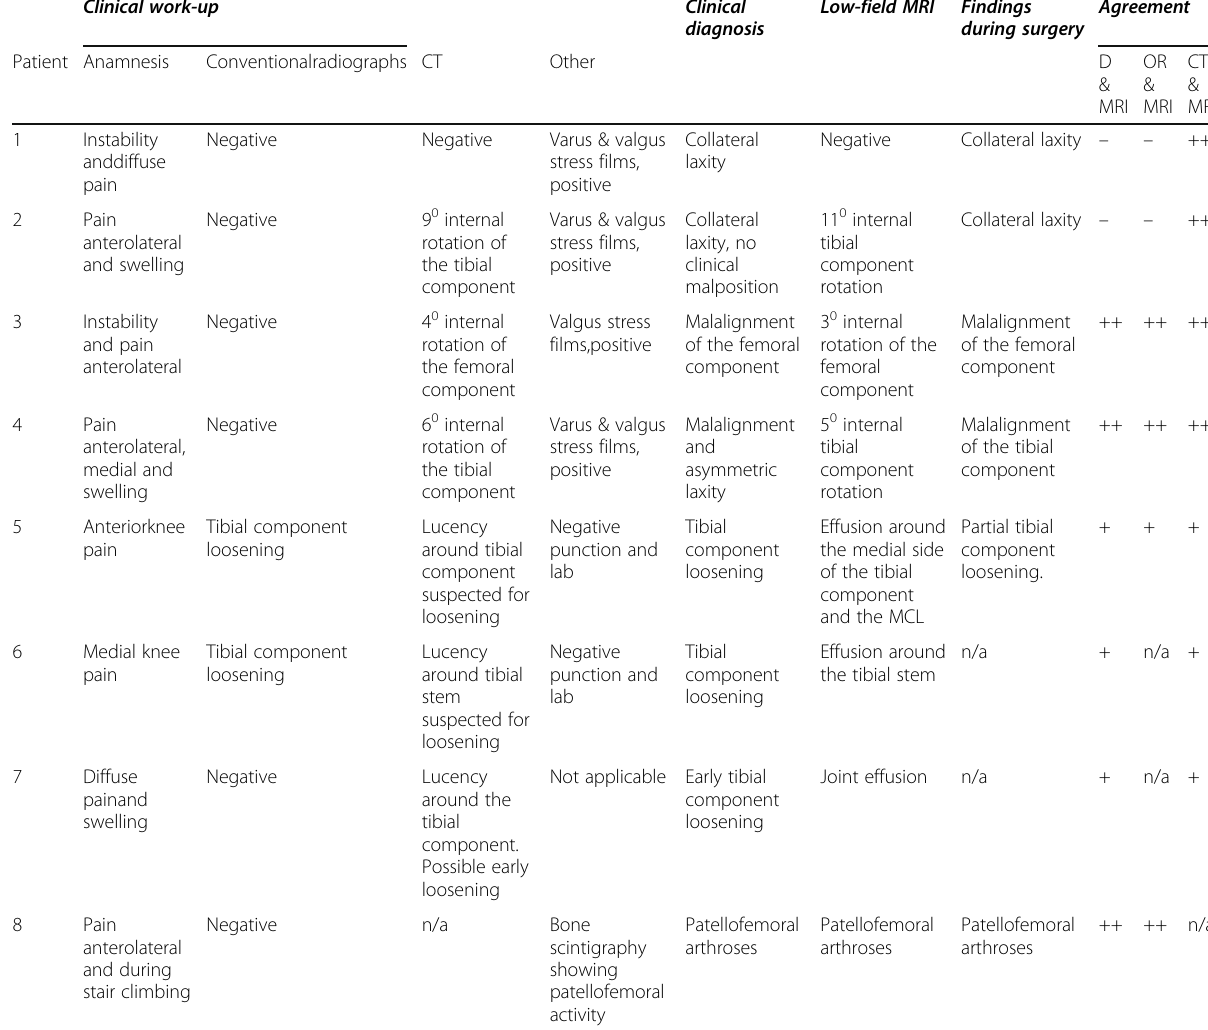
Table 1 Clinical diagnosis with additional imaging results + low-field MRI observations + findings during surgery per patient Clinical